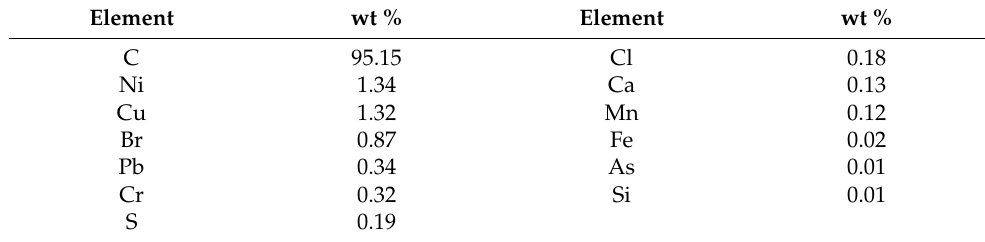
Figure 1. Physical and chemical information on the diesel exhaust particulates (DEP). ( a ) The size distribution of DEP in the cell culture medium, average diameter of 284.2 nm; ( b ) SEM image of cell culture medium, average diameter of 284.2 nm; ( b ) SEM image of DEP (magnification of 40,000 × ). DEP (magnification of 40,000×). Table 2. Elemental composition of diesel exhaust particulate matter Table 2. Elemental composition of diesel exhaust particulate matter (PM).